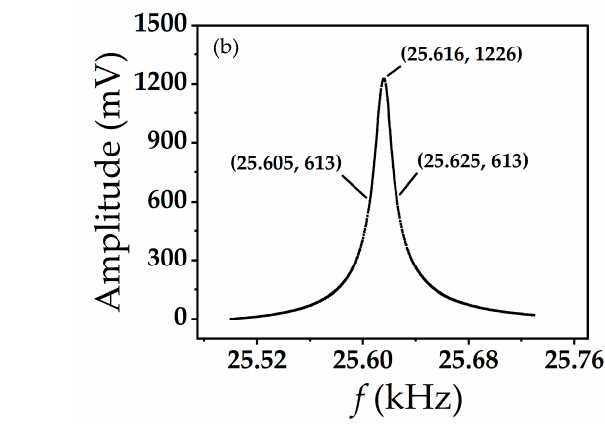
Figure 8. Q values of a balanced tuning fork probe: ( a ) Q value when the length of the tungsten tip is 1 mm; ( b ) Q value when the length of the tungsten tip is 3 mm.